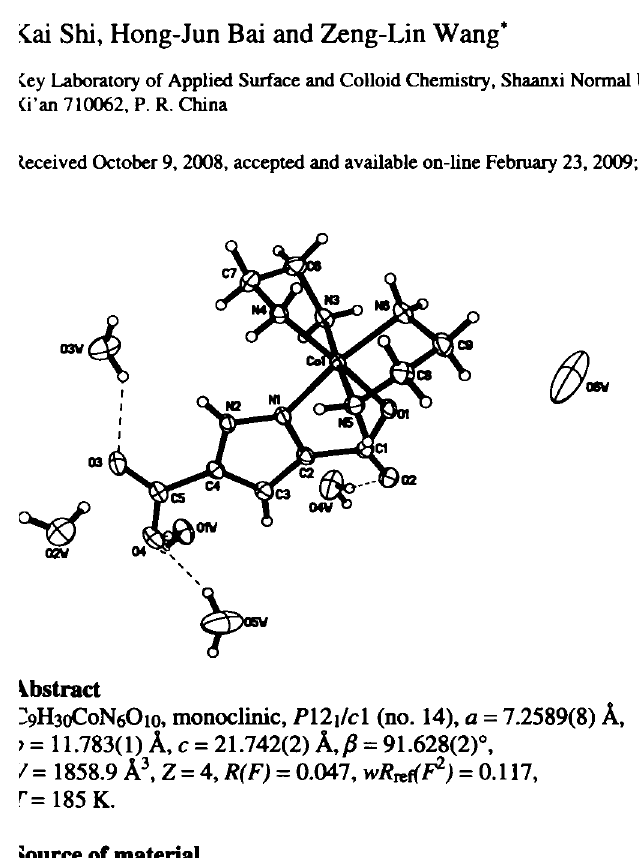
Table 1. Data collection and handling.